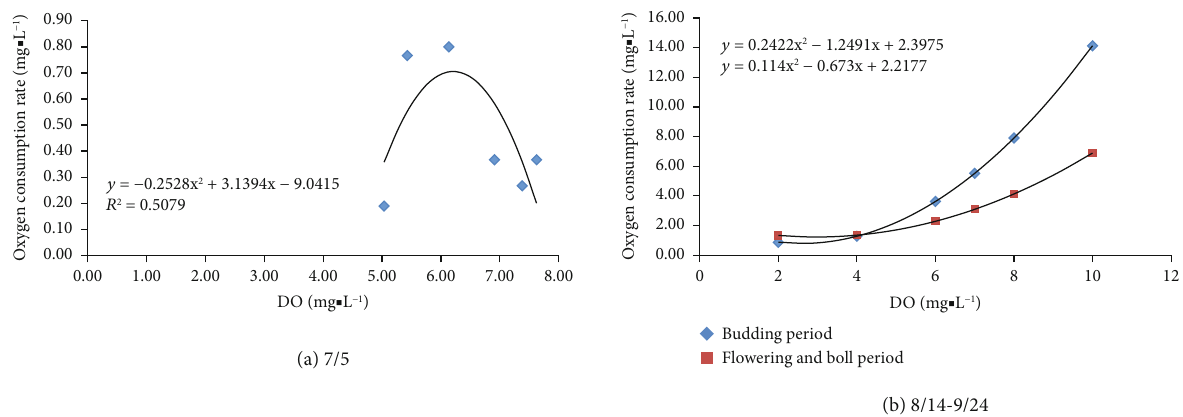
Figure 3: Changes of oxygen consumption rate of cotton in di ff erent